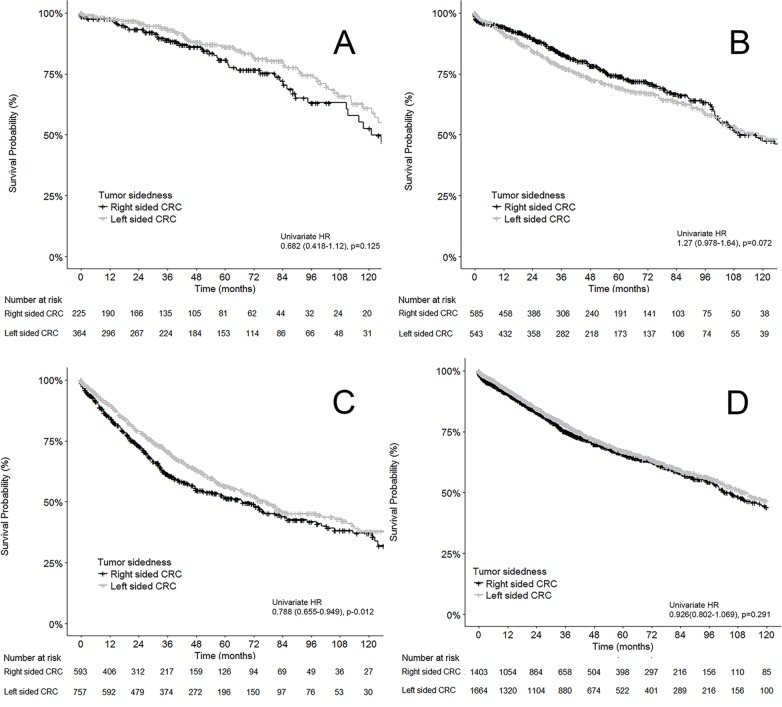
Kaplan Meier curves of the relationship between overall survival and CRC tumor sidedness.A: Stage I CRC, B: Stage II CRC, C: Stage III CRC, D: Combined stage I-III CRC.